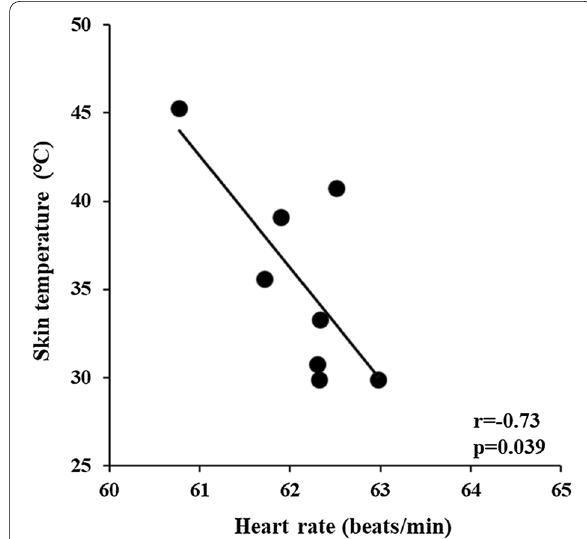
Fig. 2 Relationship between heart rate and skin temperature responses during the entire experimental period. The data used in analysis was the mean values per minute averaged over 8 min of the experimental period obtained from for all subjects (